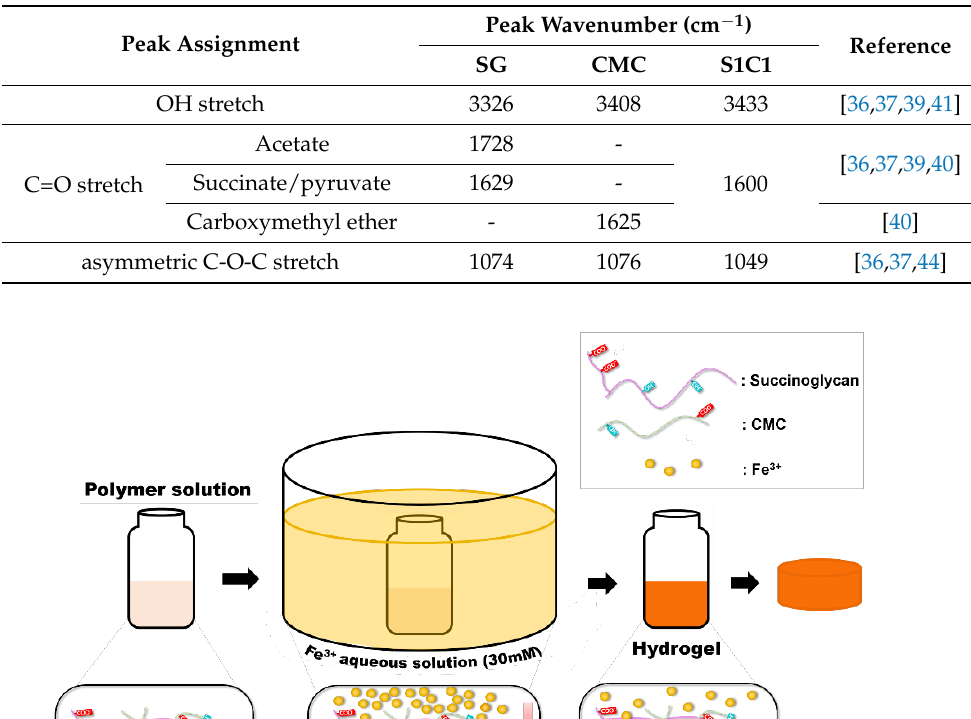
Table 2. Shift of the main peaks in the FTIR spectra of SG gel, S1C1 gel, and CMC gel.